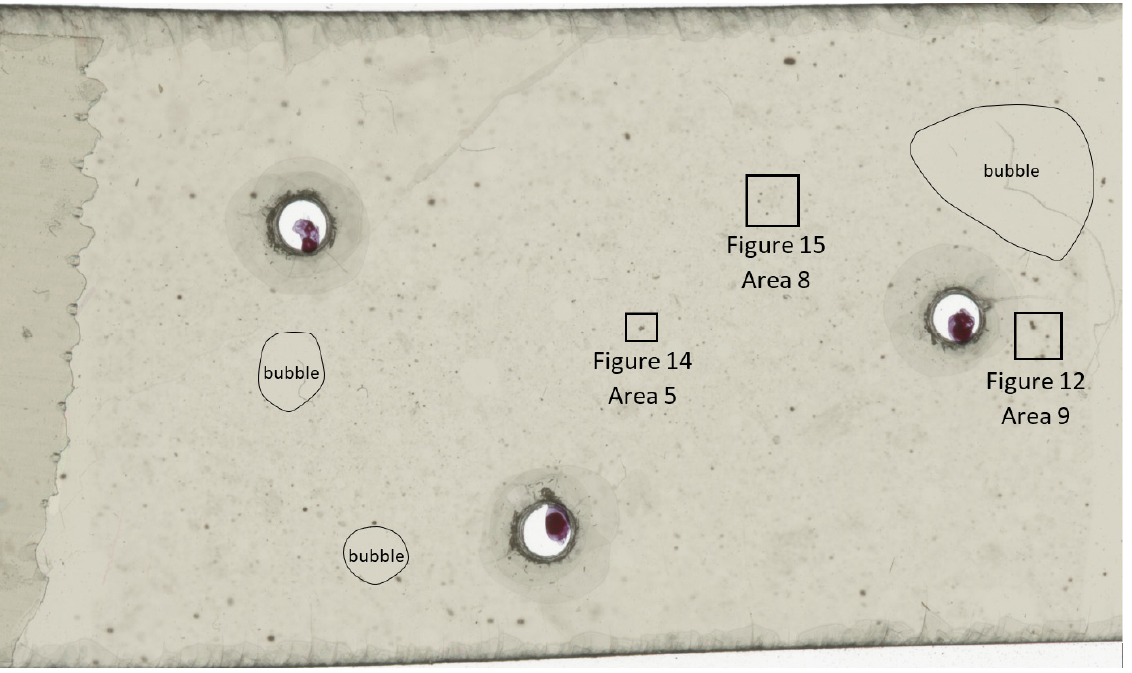
Figure 8. Fission-track mica image for GJAST-14-8 (total digestion uranium concentration of 9.92 mg/kg). Squares indicate zoomed-in areas with associated figure numbers. White circles are drill holes used to align the fission-tracked mica and the thin section. Length is 38 mm.